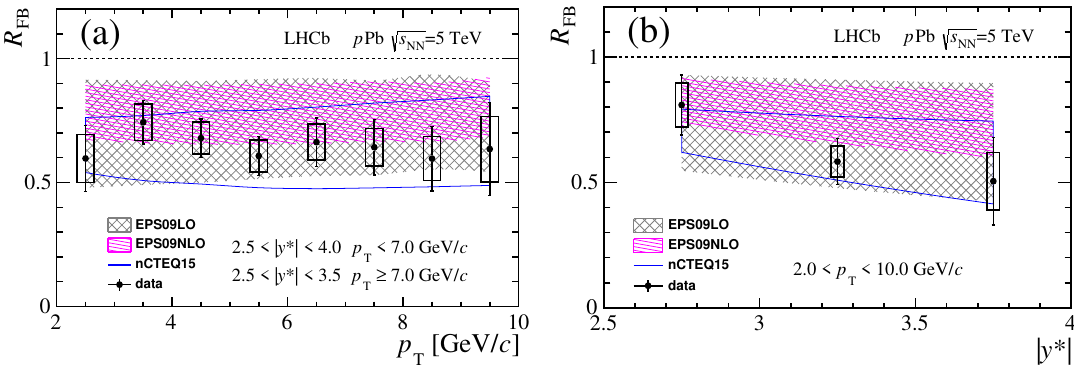
Figure 5 . (a) Forward-backward production ratios R FB as a function of p T integrated over 2 : 5